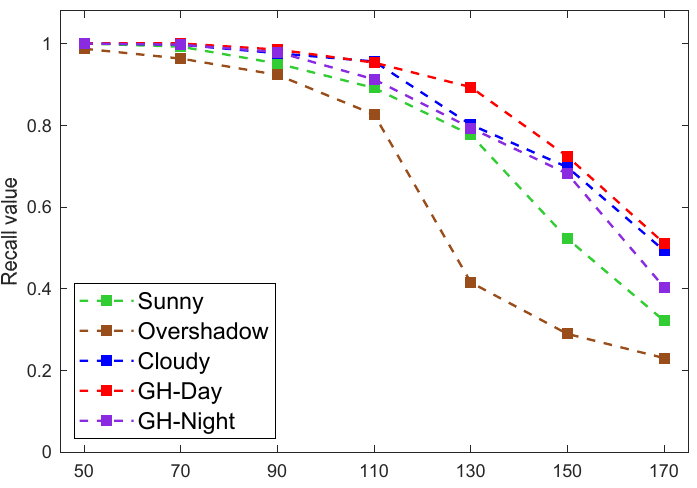
Figure 12. The average recall values at different depths.